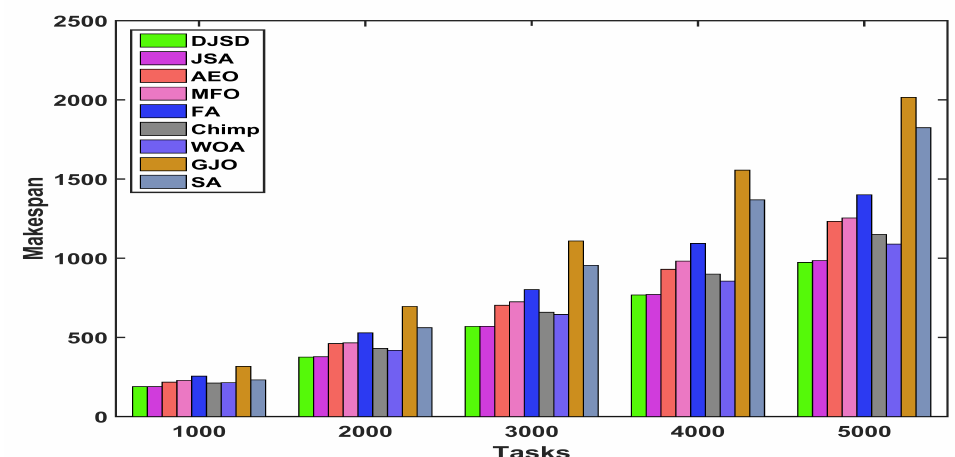
Figure 8. Average makespan for NASA iPSC real workload.